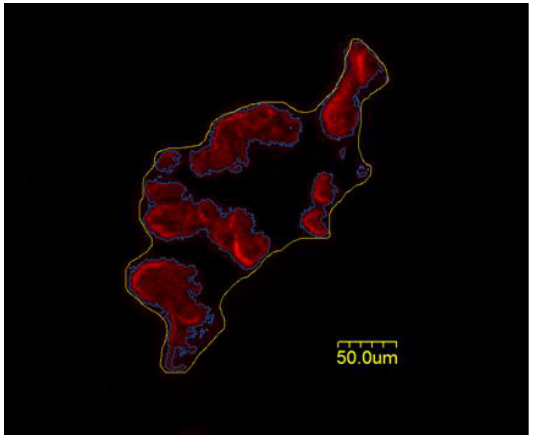
Figure 2. Representative image of tracings used to quantify post-synaptic endplate morphology. The outermost line encompassing the endplate (yellow) is manually drawn, including both stained receptors and empty regions between clusters, and used to quantify “Total Perimeter” and “Total Area,” while the innermost line (blue) is automatically drawn around clusters of ACh receptors excluding interspersed empty areas, with Image-Pro Plus software and used to quantify “Stained Perimeter” and “Stained Area.” Scale bar = 50 um.